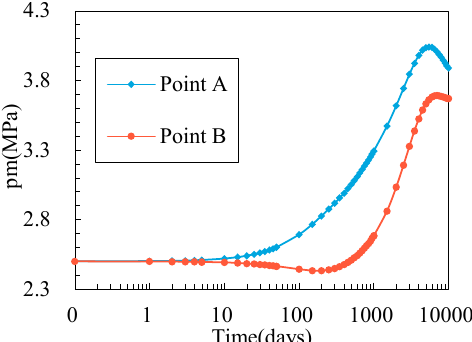
B is close to the PW. Point